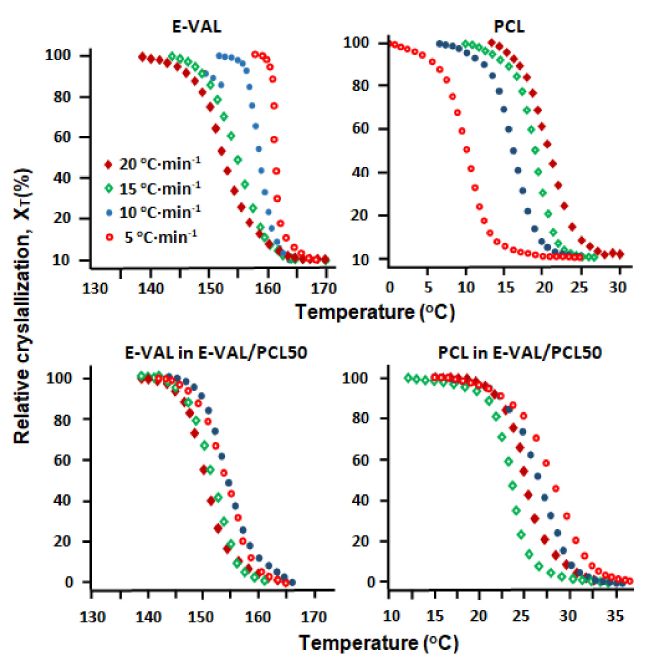
Figure 10. Variation in X T of E-VAL, PCL, E-VAL in E-VAL/PCL50, and PCL in E-VAL/PLC50 with the temperature at different crystallization rates.